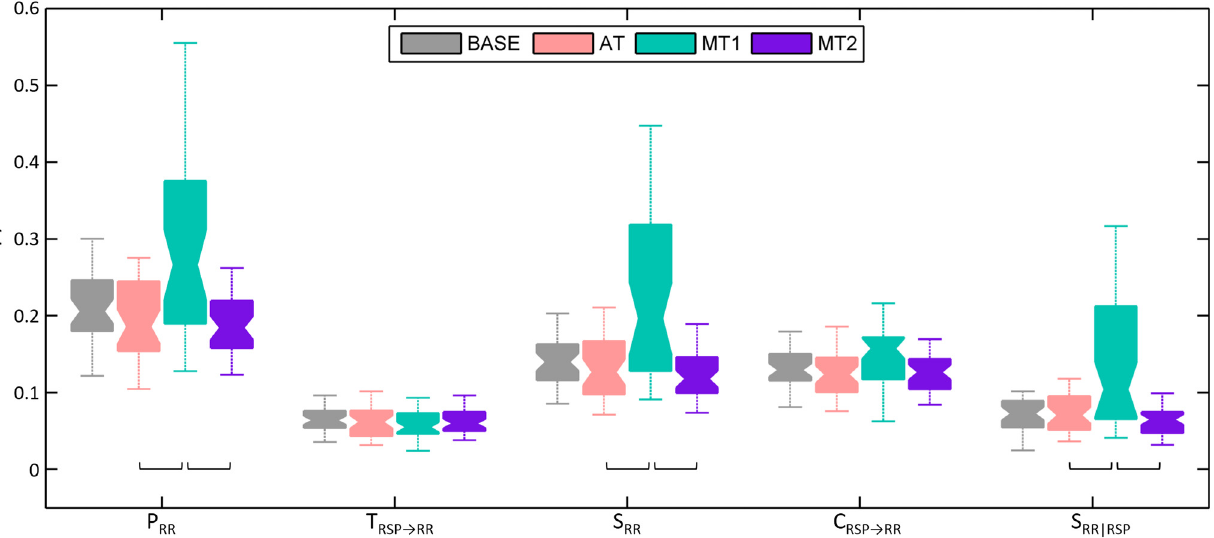
Fig 4. Boxplots of mean information-theoretic measures P RR ( p < 0.01), T RSP ! RR ( p > 0.05), S RR ( p < 0.001), C RSP ! RR ( p > 0.05) and S RR j RSP ( p < 0.01), estimated using the model-free approach using the linear surrogates as input, during baseline (BASE), sustained attention (AT) and the mental stress tasks (MT1 and MT2). The square brackets indicate significant differences between those two mental states as determined by the Friedman test and post hoc contrasts.